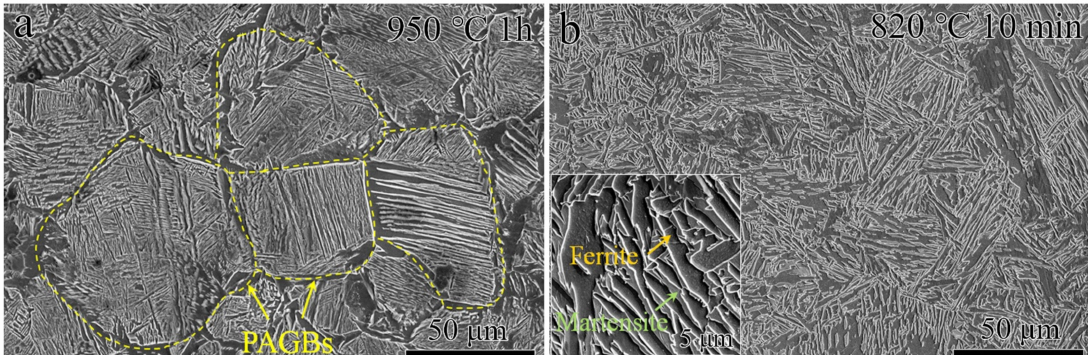
Figure 1. SEM micrographs of ( a ) lath martensite structure after austenitizing at 950 ◦ C for 60 min and water quenching, ( b ) fibrous DP microstructures after subsequent intercritical austenitizing at 820 ◦ C for 10 min and water